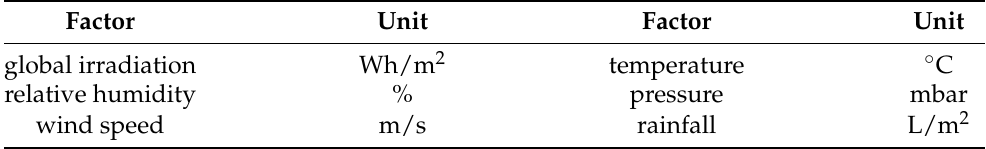
Table 2. Summary of the satellite data used in the network